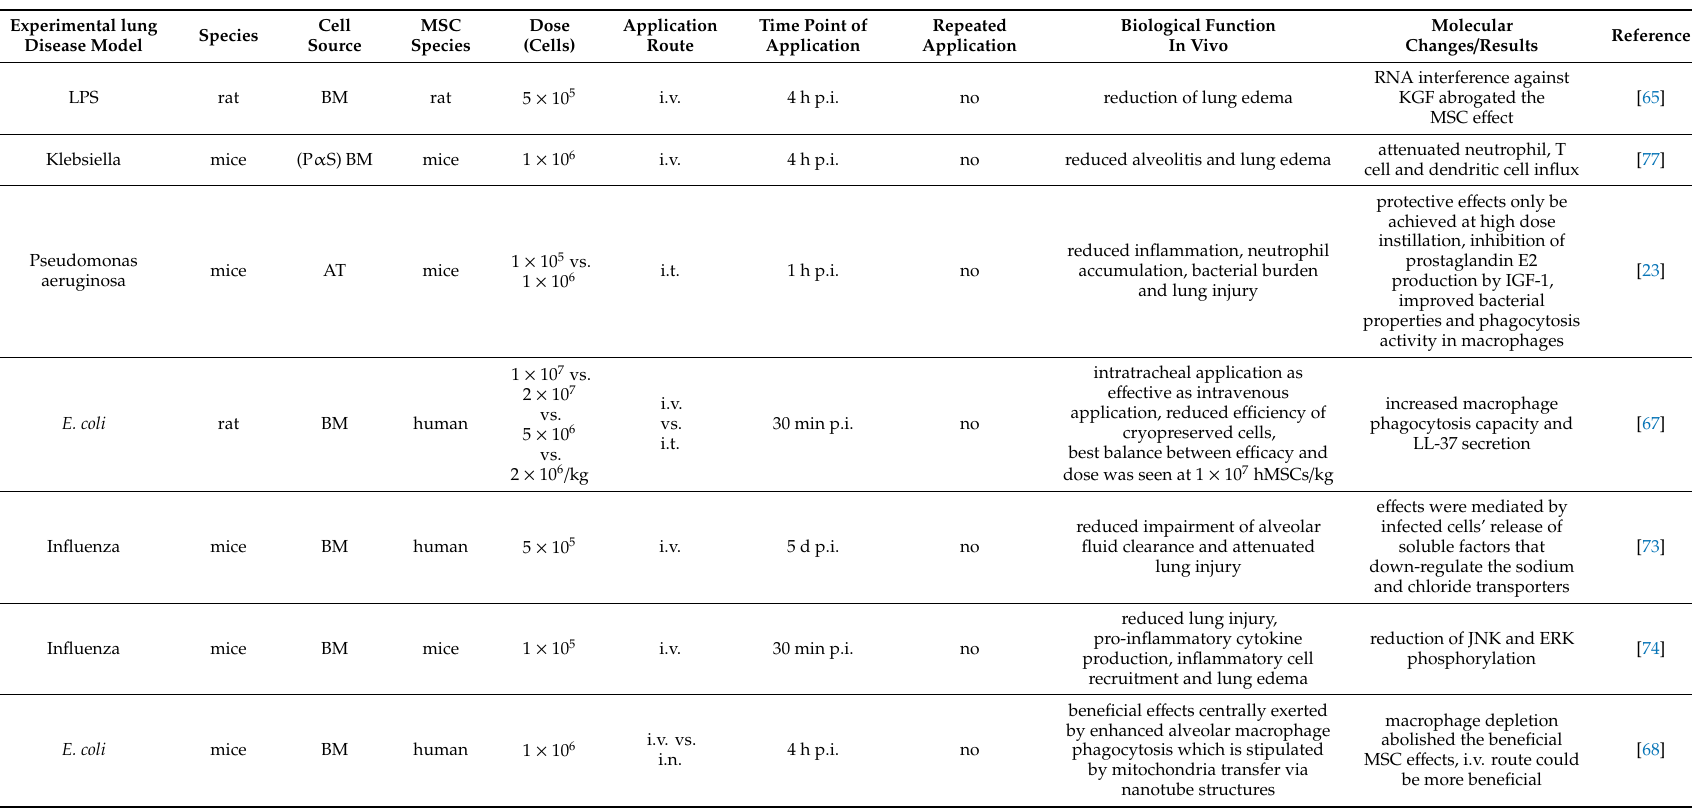
Table 3. Summary of key preclinical studies in rodents on the treatment of acute lung injury with